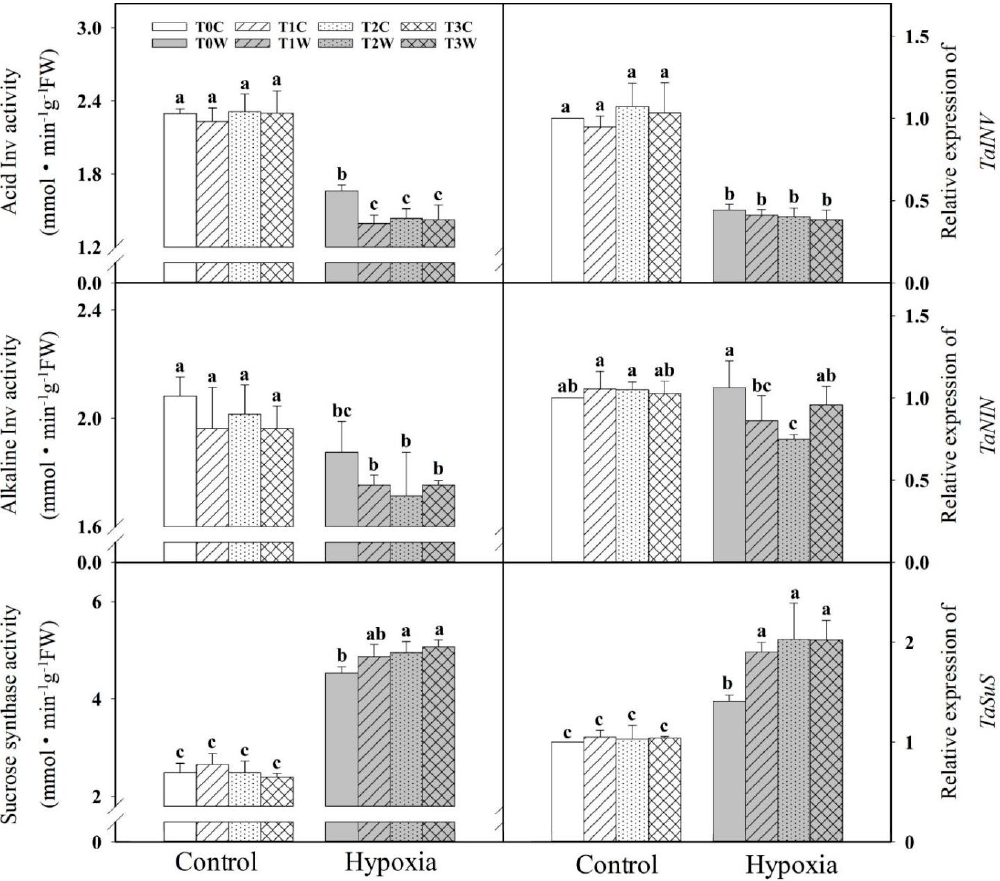
Figure 4. Effects of waterlogging-priming on acid invertase activity, alkaline invertase activity and sucrose synthase activity in root of offspring plants under hypoxia stress in wheat seedling. Note: TaAINV : acid invertase gene; TaNIN : alkaline/neutral invertase gene; TaSuS : sucrose synthase gene. T0C, no priming + no offspring hypoxia stress; T0W, no priming + offspring hypoxia stress; T1C, one-generation priming + no offspring hypoxia stress; T1W, one-generation priming + offspring hy- poxia stress; T2C, two-generation priming + no offspring hypoxia stress; T2W, two-generation prim- ing + offspring hypoxia stress; T3C, three-generation priming + no offspring hypoxia stress; T3W, three-generation priming + offspring hypoxia stress. Data are means ± SE (n = 3). Different lowercase letters indicate the significant difference at p < 0.05 level.